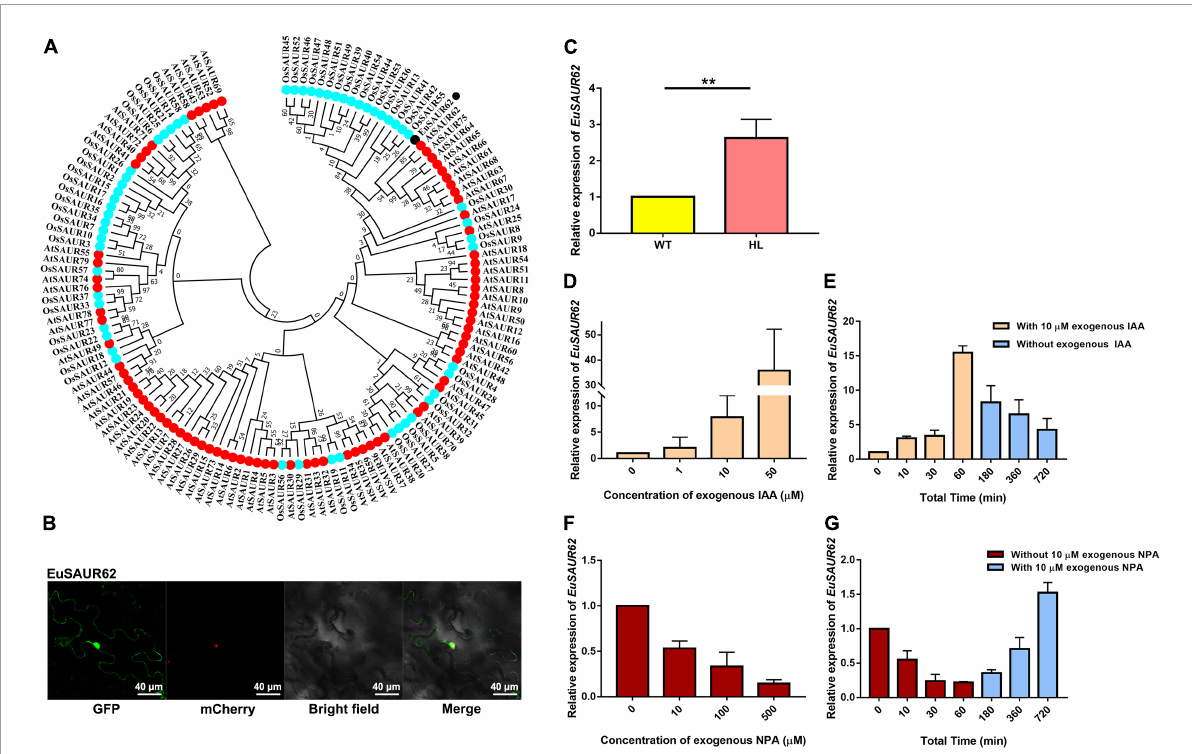
FIGURE4 Classification and auxin response of EuSAUR62 . (A) Phylogenetic relationships of EuSAUR62 and SAURs from Arabidopsis thaliana and Oryza sativa . SAURs from Arabidopsis and rice are displayed in red and cyan, respectively. EuSAUR62 (black) is next to AtSAUR62 and AtSAUR75. (B) The subcellular localization of EuSAUR62 in tobacco leaves. EuSAUR62 was fused to GFP and transfected into tobacco leaves. A merged image including bright field, H2B-mCherry and GFP fluorescence was observed using a confocal laser scanning microscope (Scale bar = 40 µ m). (C) Relative expression of EuSAUR62 in the fruits of WT and HL was detected using qRT-PCR. qRT-PCR analyses of EuSAUR62 expression in 2-week-old WT seedlings after treating with different doses of exogenous IAA (0, 1, 10, 50 µ M) for 1 h (D) or with 10 µ M exogenous IAA from 0 to 60 min, followed by replacing the IAA solution with pure water (E) . The time points of IAA treatment are shown in orange columns, whereas water culturing is expressed in blue columns. Euryale Actin was used as an internal control. Relative expression of EuSAUR62 in WT seedlings following 1 h treatment of 0, 10, 100, or 500 µ M exogenous NPA (F) , an auxin transport inhibitor, or with 10 µ M exogenous NPA treatment for 1 h before water culturing (G) . The time points of NPA treatment are shown in crimson columns, whereas water culturing is expressed in blue columns. Two-tail Student’s t -test was used for statistical analysis; Data are mean ± SD. * p < 0.05. HL, hybrid Euryale lines; IAA, Indole-3-acetic acid; NPA, N -1-naphthylphthalamic acid; WT, wild type (North Gordon